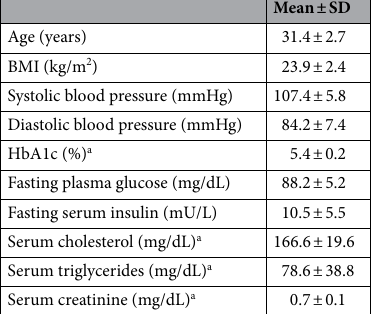
Table 1. Subject characteristics and metabolic profile of the 05 study subjects. Data are mean ± SD. a Fasted blood sample.